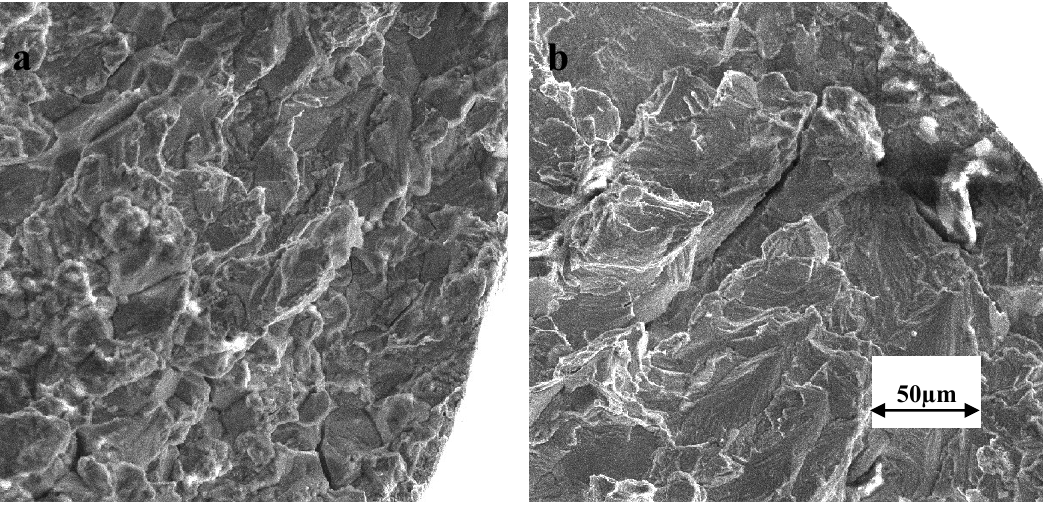
Figure 6. SEM fractograph of 316L tested in 30 wt. % MgCl 2 at 150 °C at 3.7 × 10 −7 s −1 , showing: ( a ) intergranular SCC (IGSCC) in solution with 0, 1400 and 2800 ppm NO 2− , and ( b ) trans-granular SCC (in addition to IGSCC) in solution with 5600 ppm NO 2− .